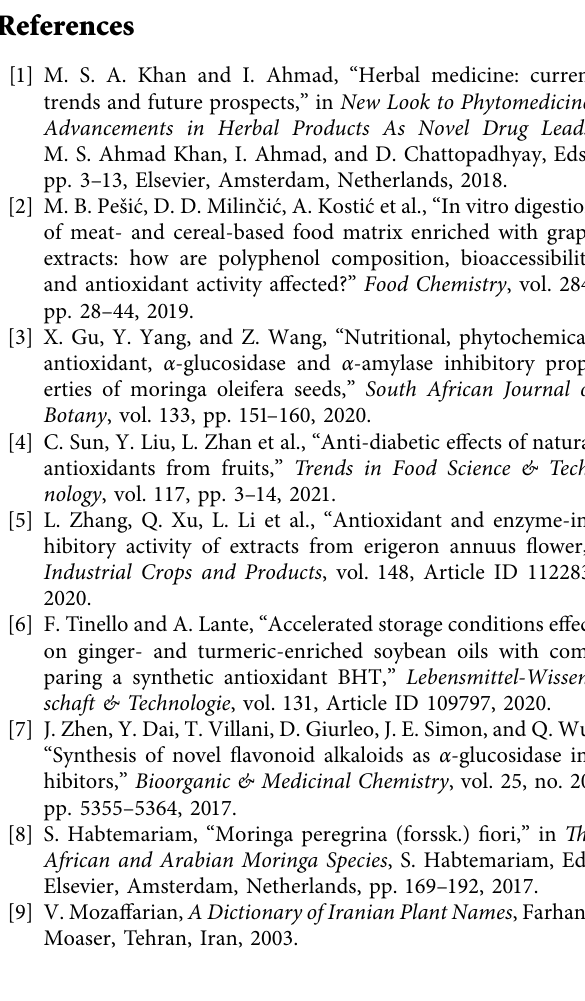
1 values are expressed as mean ± standard error ( n � 3) and different lowercase letters in the same columns show significant differences ( p < 0 . 05). 2 mal- todextrin. 3 maltodextrin/Arabic gum. 4 maltodextrin/modified starch. 5 maltodextrin/extract. 6 maltodextrin/Arabic gum/extract. 7 maltodextrin/modified